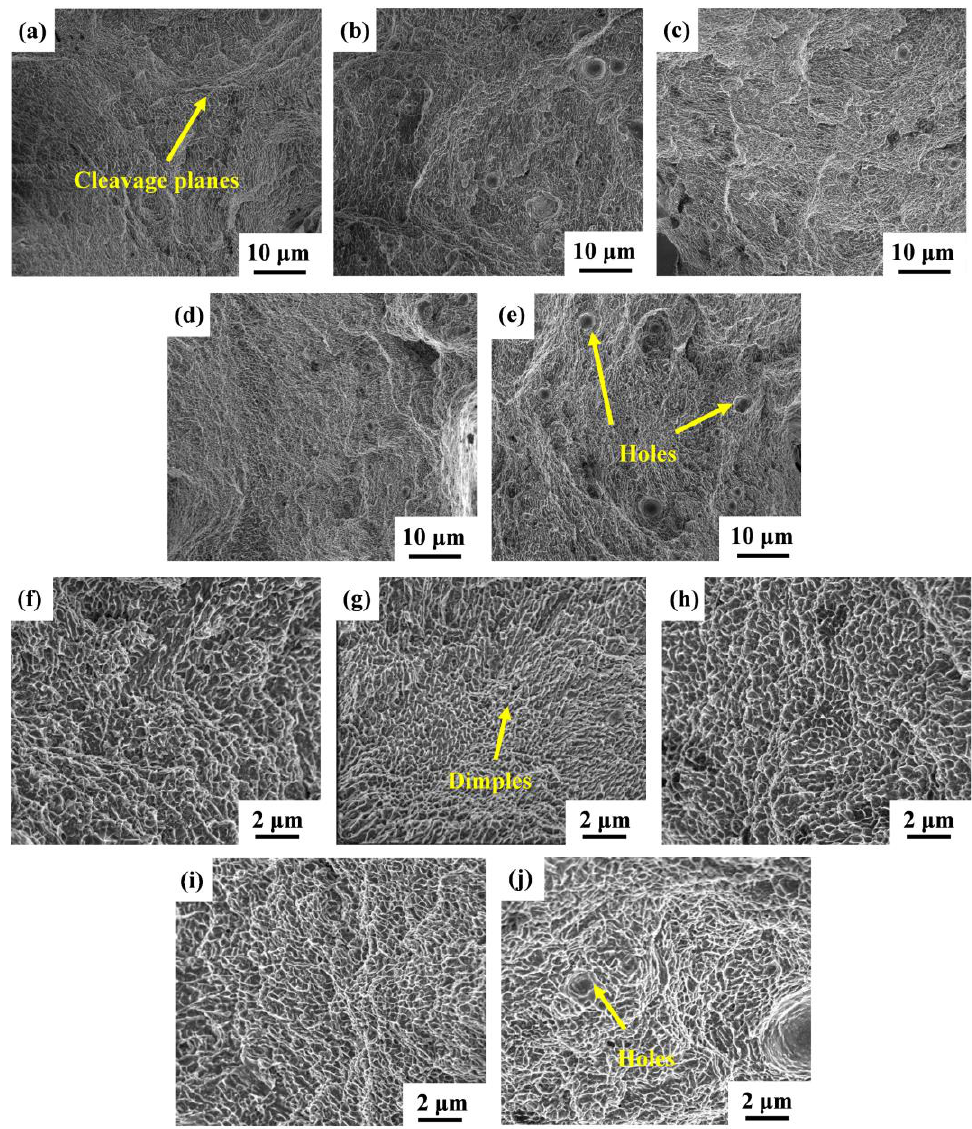
Figure 13. SEM images of fracture surfaces: ( a , f ) for S0; ( b , g ) for S1; ( c , h ) for S2; ( d , i ) for S3; ( e , j ) for S4.